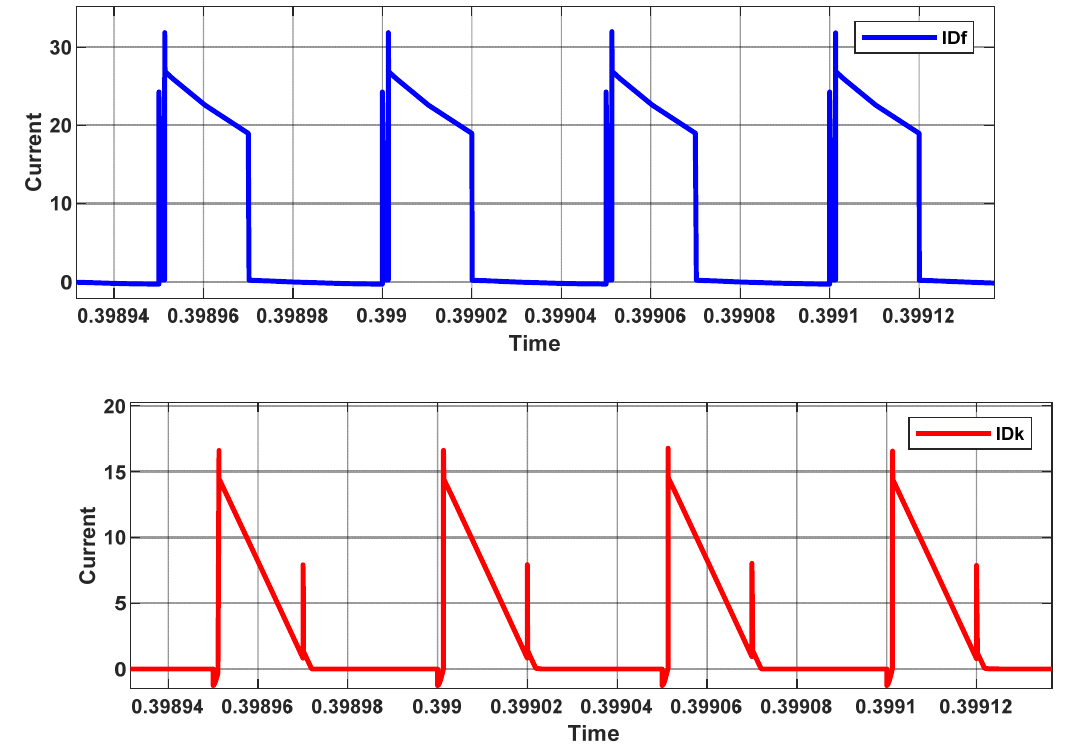
Figure 9. The diode currents in the proposed HFC converter, I Df (blue), and I Dk (red).